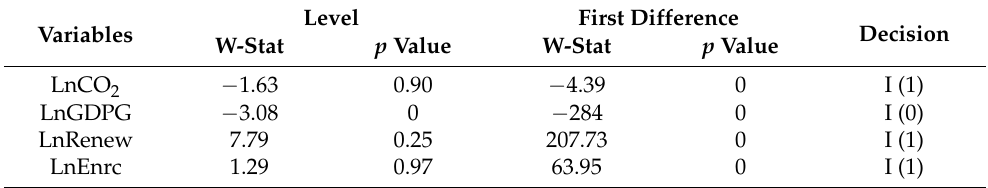
Table 4. Cross Sectional Im, Pesaran, and Shin (CIPS) Panel Unit Root Results.